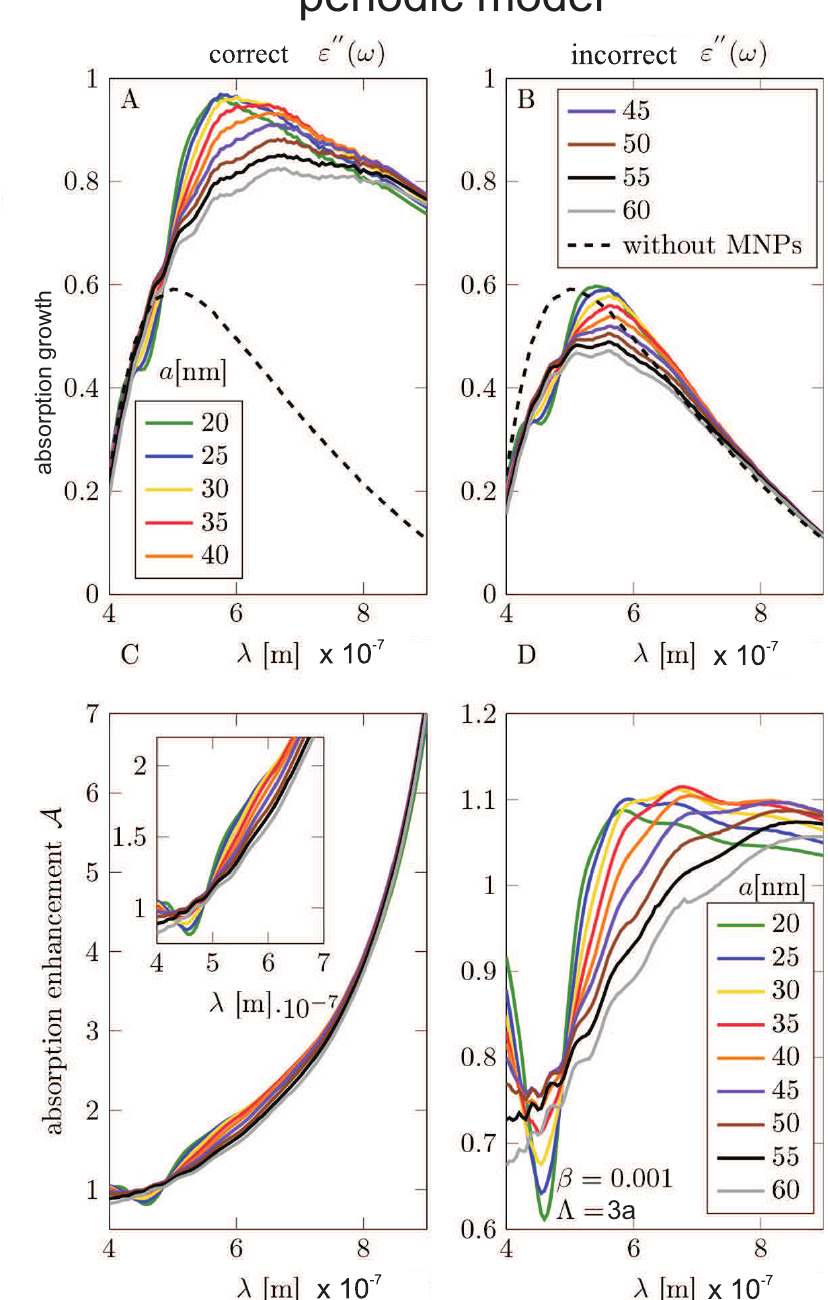
Figure 7. The periodic model—( A , B ): The absorption enhancement in the Si substrate as the function of the wavelength of incident electromagnetic wave for varying radius of metallic nanoparticles. ( C , D ): The efficiency rate growth acc. Equation (27) as a function of the wavelength of incident electromagnetic wave for varying radius of nanoparticles. ( A , C ): The results obtained in the model using modified ′′ ( ε ω ) ; ( B , D ): The results obtained in the model using inappropriate (non-modified) dielectric function taken from the measurement in bulk [42]. The calculation was made for MNP arrays with the period equal Λ = 3 a and the radius a = 20, 25, 30, 35, 40, 45, 50, 55, 60